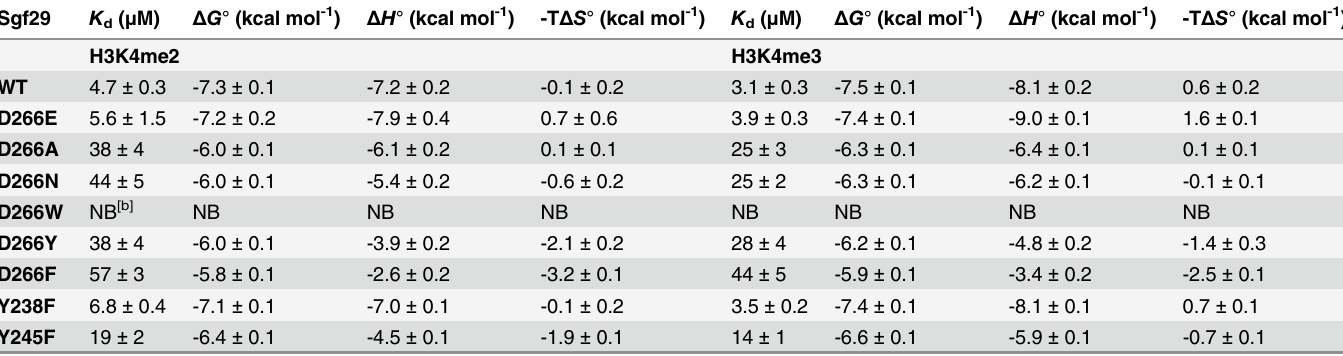
Table 2. Thermodynamic parameters for binding of histone H3K4me2 and H3K4me3 peptides to Sgf29 variant proteins. [a]